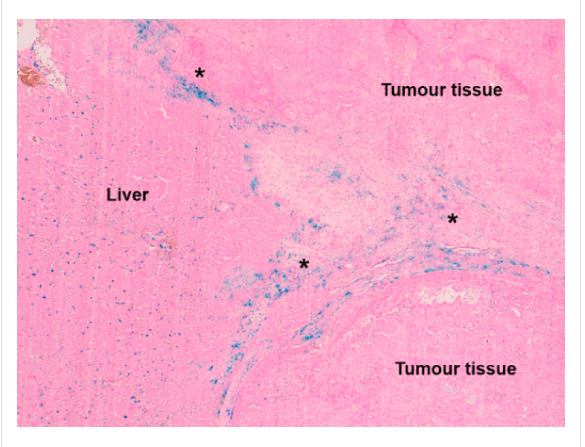
Figure 5: Kupffer cells with phagocytized iron deposits (blue dots) in liver tissue. In the fibro-vascular tissue matrix around the tumor (aster- isks) blue iron deposits are